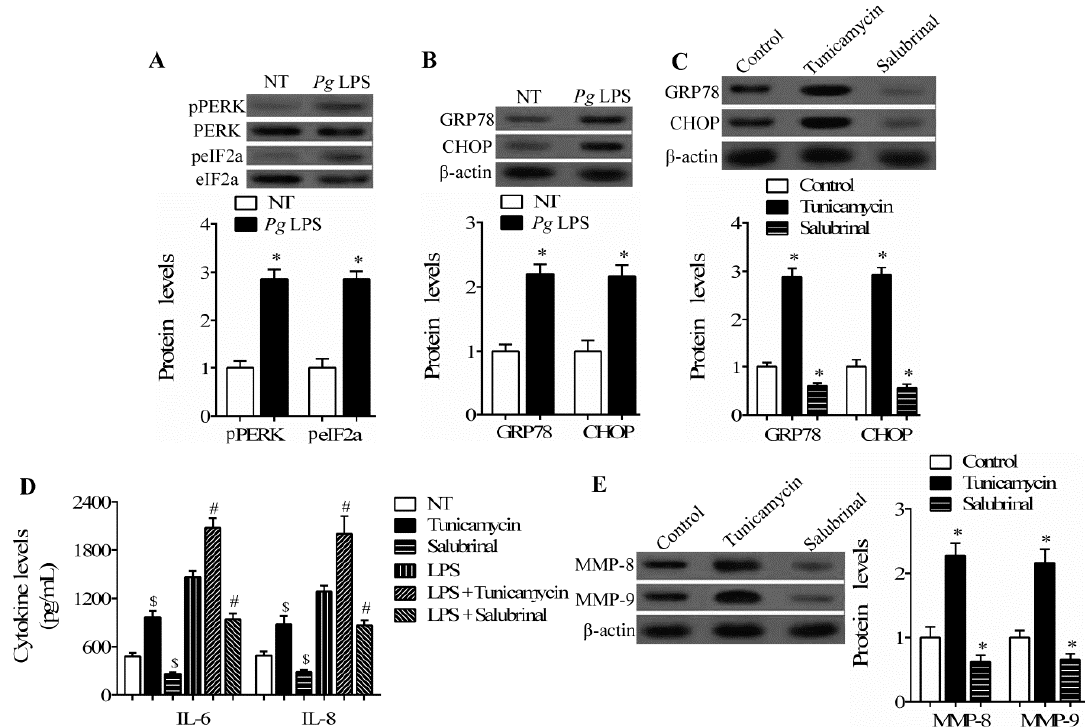
Figure 3. The role of ER stress induced by LPS in hPDLCs. hPDLCs were incubated with 1 μ g/mL P. gingivalis LPS for 24 h. ( A ) The phosphorylation of protein kinase-like ER kinase (PERK), eIF2 α and ( B ) the expression of GRP78/Bip and C/EBP homologous protein (CHOP) in hPDLCs were measured by Western blotting (* p < 0.05 vs. NT); ( C ) hPDLCs were pretreated with 5 μ g/mL tunicamycin or 10 μ M salubrinal for 2 h, followed by stimulation with P. gingivalis LPS for 24 h. The levels of GRP78/Bip and CHOP in hPDLCs were measured by Western blotting to confirm the efficiency of salubrinal and tunicamycin; ( D ) the levels of IL-6 and IL-8 were analyzed by ELISA in hPDLCs treated with salubrinal or tunicamycin in the presence or absence of LPS; and ( E ) Western blotting was used to measure the expression of MMP-8 and MMP-9 in hPDLCs stimulated with LPS. Untreated hPDLCs were stimulated by P. gingivalis LPS and used as the control. ($ p < 0.05 vs. NT; # p < 0.05 vs. LPS; * p < 0.05 vs. control).